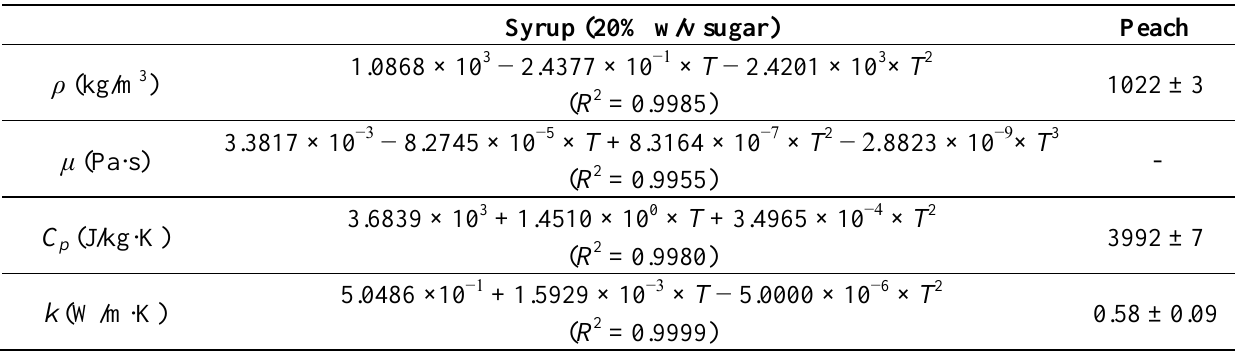
Table 1. Physical and thermal properties of liquid and solids used in